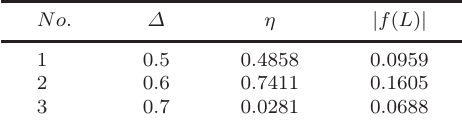
Table 1. The values of η and | f ( L ) | for δ = 0 , I = 0 . 01 .